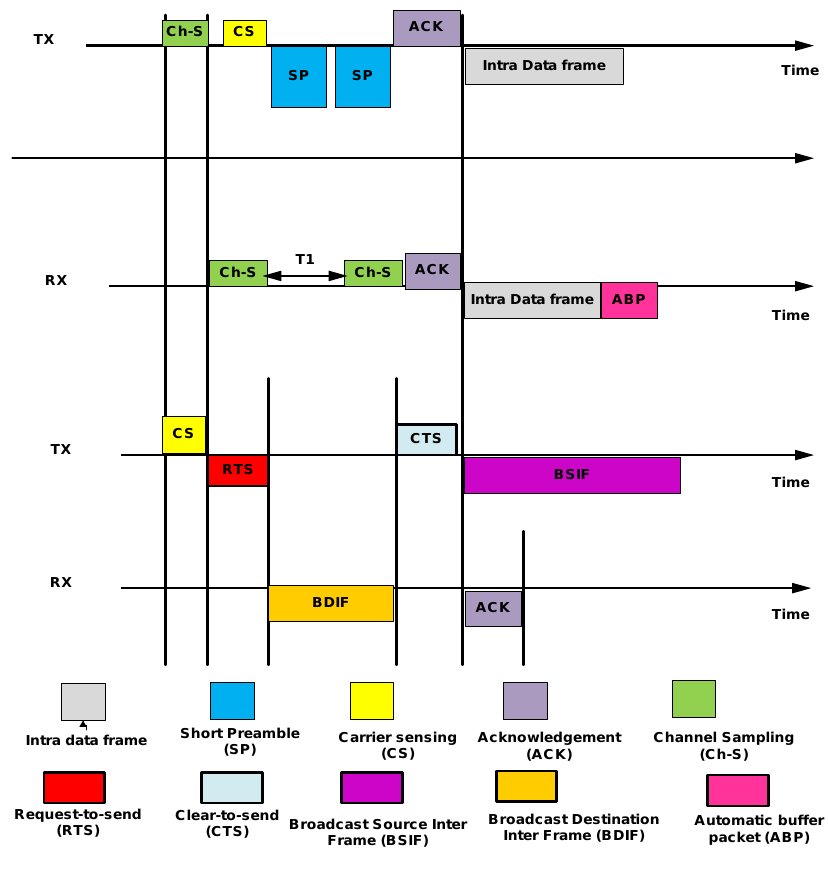
Figure 12. Message mechanism of the hybrid BN-MAC